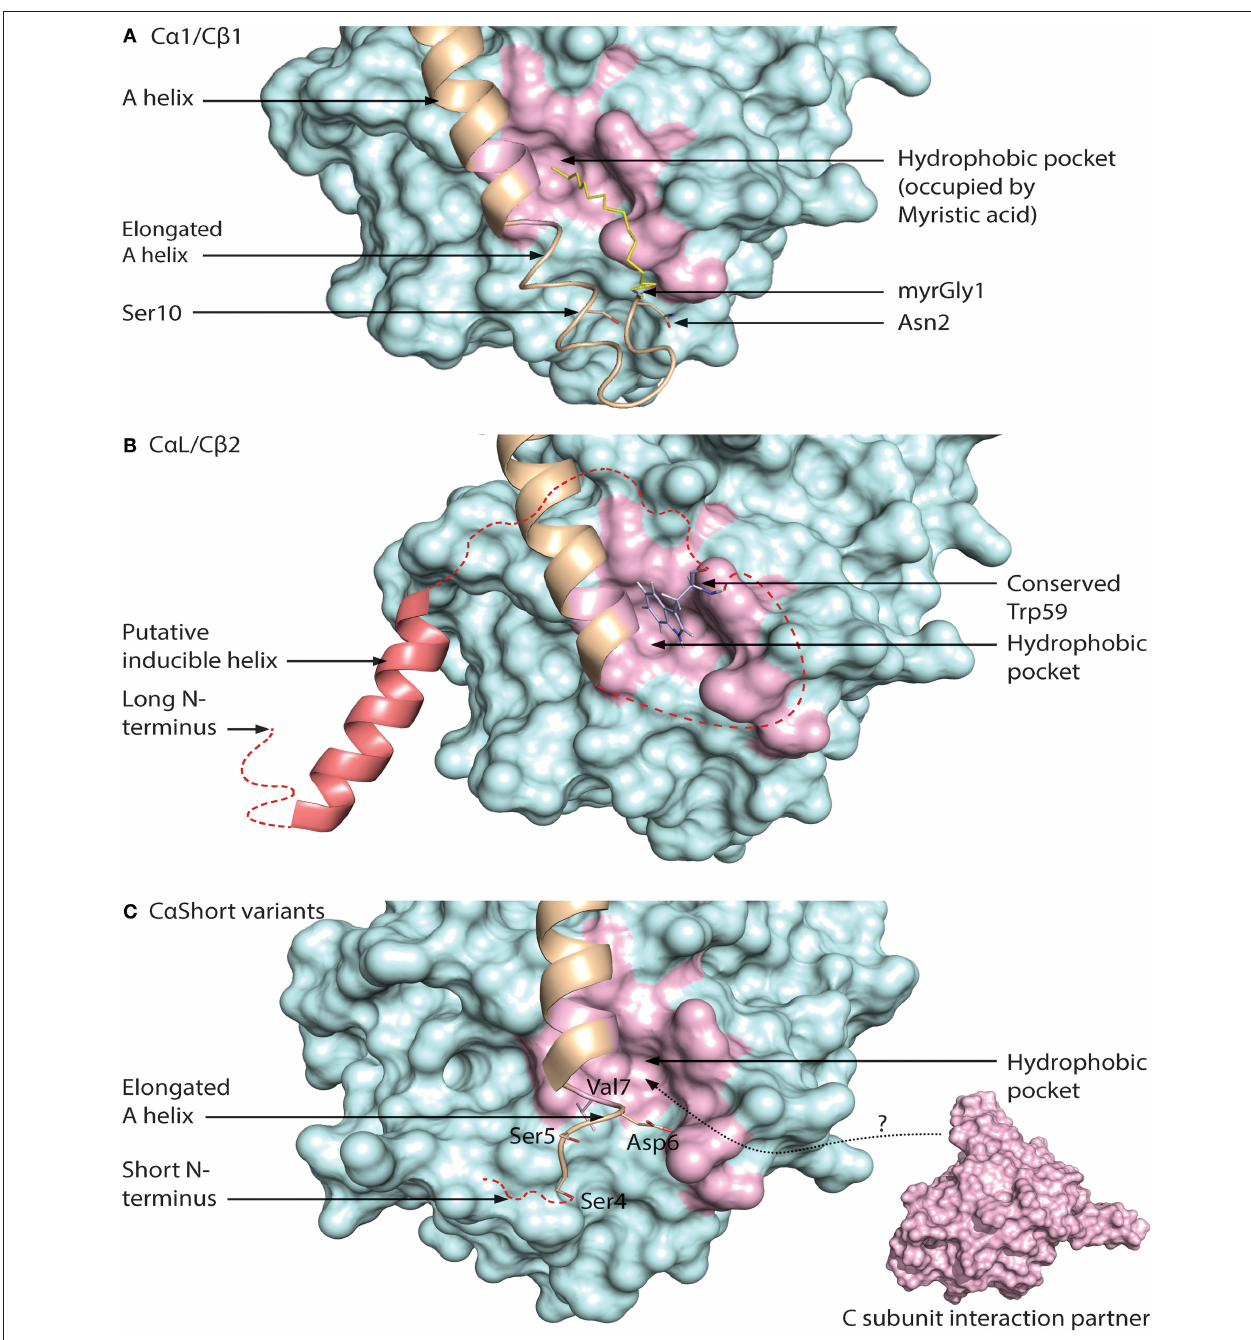
FIGURE 5 | Different configurations of N terminal parts of C subunit isoforms. For all figures, the C subunit is represented in cyan with the hydrophobic pocket highlighted in purple. Alternative exon 1 encoded parts of the C subunit are in orange cartoon presentation, in addition to the mainly exon 2 encoded A helix. Hypothesized (i.e., not supported by published crystal structure data) structures of N-terminal residues are colored red. (A) Representation of human myristoylated C α 1. The structure of unphosphorylated (Ser10), unmodified (i.e., not deamidated) Asn2, and Gly1-myristoylated C α 1 shows a fully ordered N-terminus. The modifiable residues in the 5 ′ encoded exon are highlighted in stick presentations, and myristic acid (yellow) occupies the hydrophobic pocket. Based on the structure with PDB identifier 1CMK (73). (B) Proposed model of N-terminal structure of C α L/C β 2 homologs. Our study identified a conserved Trp59 (human C β 2 numbering) (stick presentation, slate) residue which potentially occupies the hydrophobic pocket. The most conserved part of the N-terminus was predicted to encode a helix structure, which we hypothesize may be ordered upon binding to interaction partners. The figure is modeled from the experimental structure of C α 1, with the N-terminal residues encoded by exon 1 modeled. PDB identifier 1CMK (73). (C) Proposed model of N-terminal structure of C α Short variants. Short N-terminal transcripts in C α were identified in most vertebrate species investigated. The short N-terminal end displays the open hydrophobic pocket as earlier proposed for C α 2. The figure is based upon the experimental structure of human C α 2 with PDB identifier 4AE9 (63).